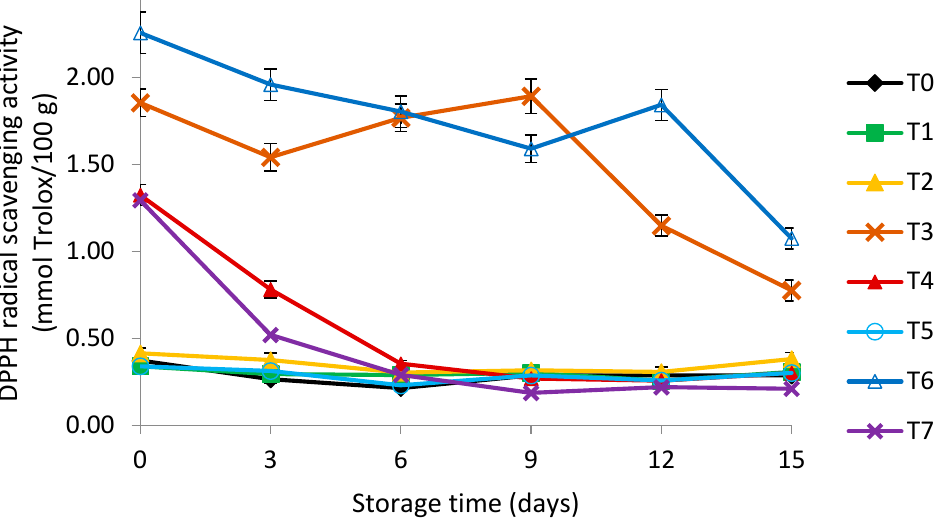
Figure 8. DPPH radical-scavenging activity of control and treated fresh-cut pears stored for 15 days at 8 ± 1 °C. T0—Control; T1—0.2% PE + 1% CaCl 2 ; T2—0.2% PE + 1% CaCl 2 + 0.2% PS; T3—0.2% PE + 1% CaCl 2 + 0.2% PS + 1% N -AC; T4—0.2% PE + 1% CaCl 2 + 0.2% PS + 1% CA + 1% AA; T5—0.2%